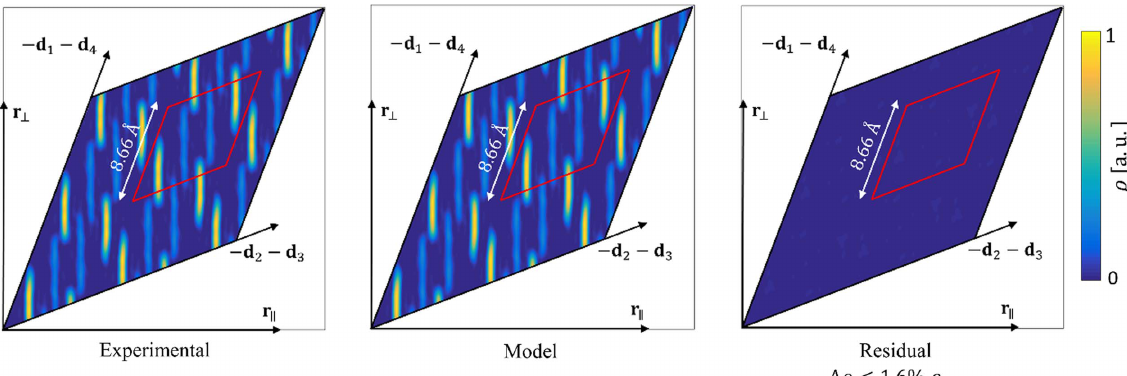
Figure 14 2D section through the electron density map recovered on the phases of the peaks coming from the refinement. The experimental amplitudes, coming from the model and their differences, were used to recover density maps. The residual electron density is lower than the potential atom, therefore we can conclude that our model does not miss any